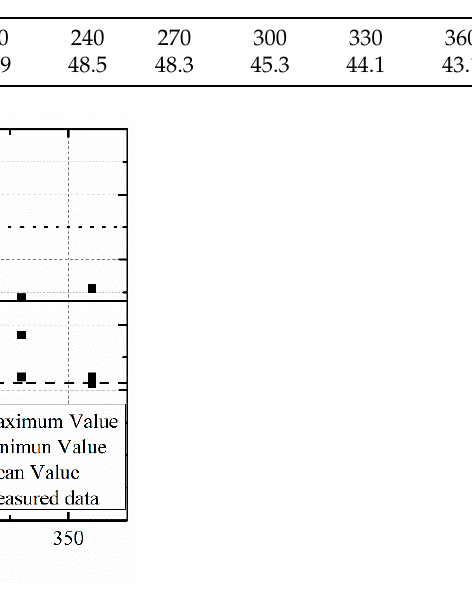
Table 4. MOV response time.